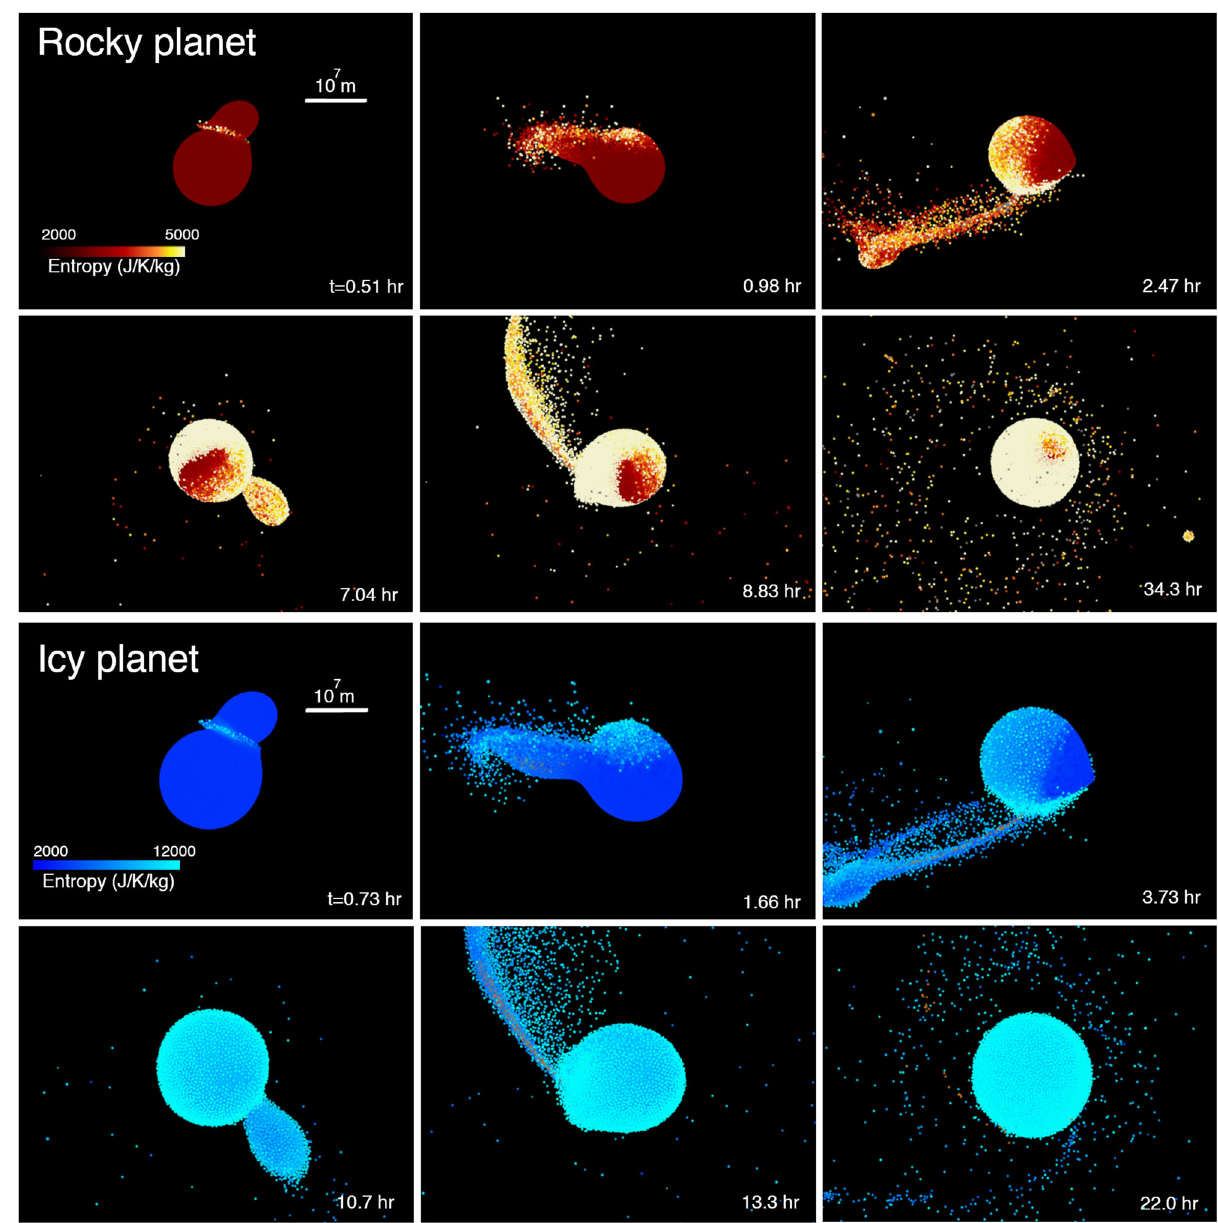
Fig. 1 Snapshots of giant impacts (Runs ID2 and ID20, Table 1). The top two rows represent an impact between two rocky planets. The red-orange colors represent the entropy of the mantle material (forsterite). The iron core is shown in gray. The bottom two rows represent an impact between two icy planets. The blue-sky-blue colors represent the entropy of water ice, and the orange color represents forsterite. The scale represents 10 7